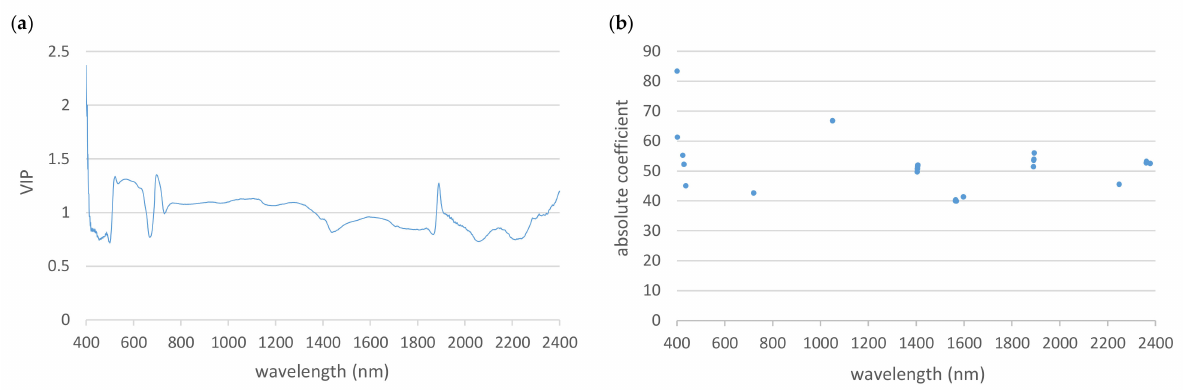
Figure 8. Variable importance for raw reflectance data computed by PLSR ( a ), and support vector regression (SVR) based on variables selected by cross-validated recursive feature elimination (RFECV) ( b ).